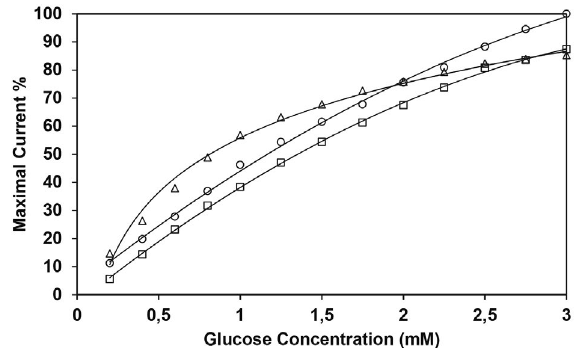
Figure 3. Current response of PPy based electrode prepared apply- ing different scan rates;  : 20 mV/s; O: 50 mV/s;  : 100